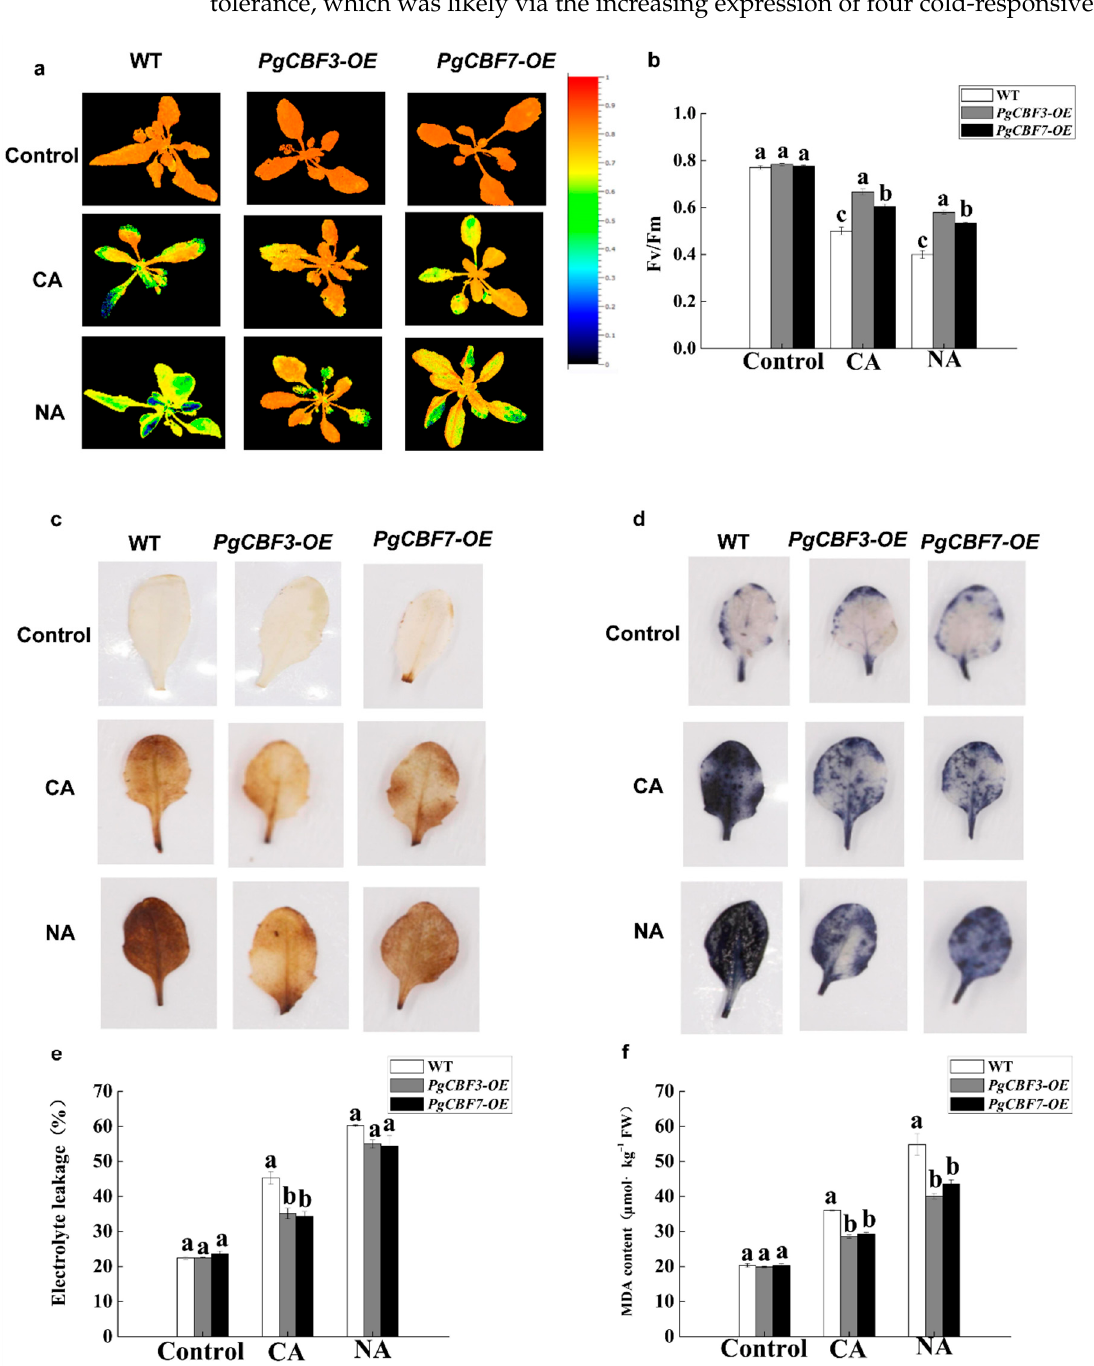
Figure 6. Change trends of physiological parameters of transgenic lines and WT plants under freezing treatment. The chlorophyll fluorescence image ( a ) and Fv/Fm values ( b ) of PgCBF3 and PgCBF7 transgenic Arabidopsis under freezing stress; ( c ) H 2 O 2 accumulation by DAB chemical staining; ( d ) detection of O 2- by NBT chemical staining electrolyte leakage ( e ) and MDA ( f ) content of PgCBF3 and PgCBF7 transgenic Arabidopsis at freezing temperature. Different letters present significant differences ( p < 0.05). CA: cold-acclimated; NA: non-acclimated.